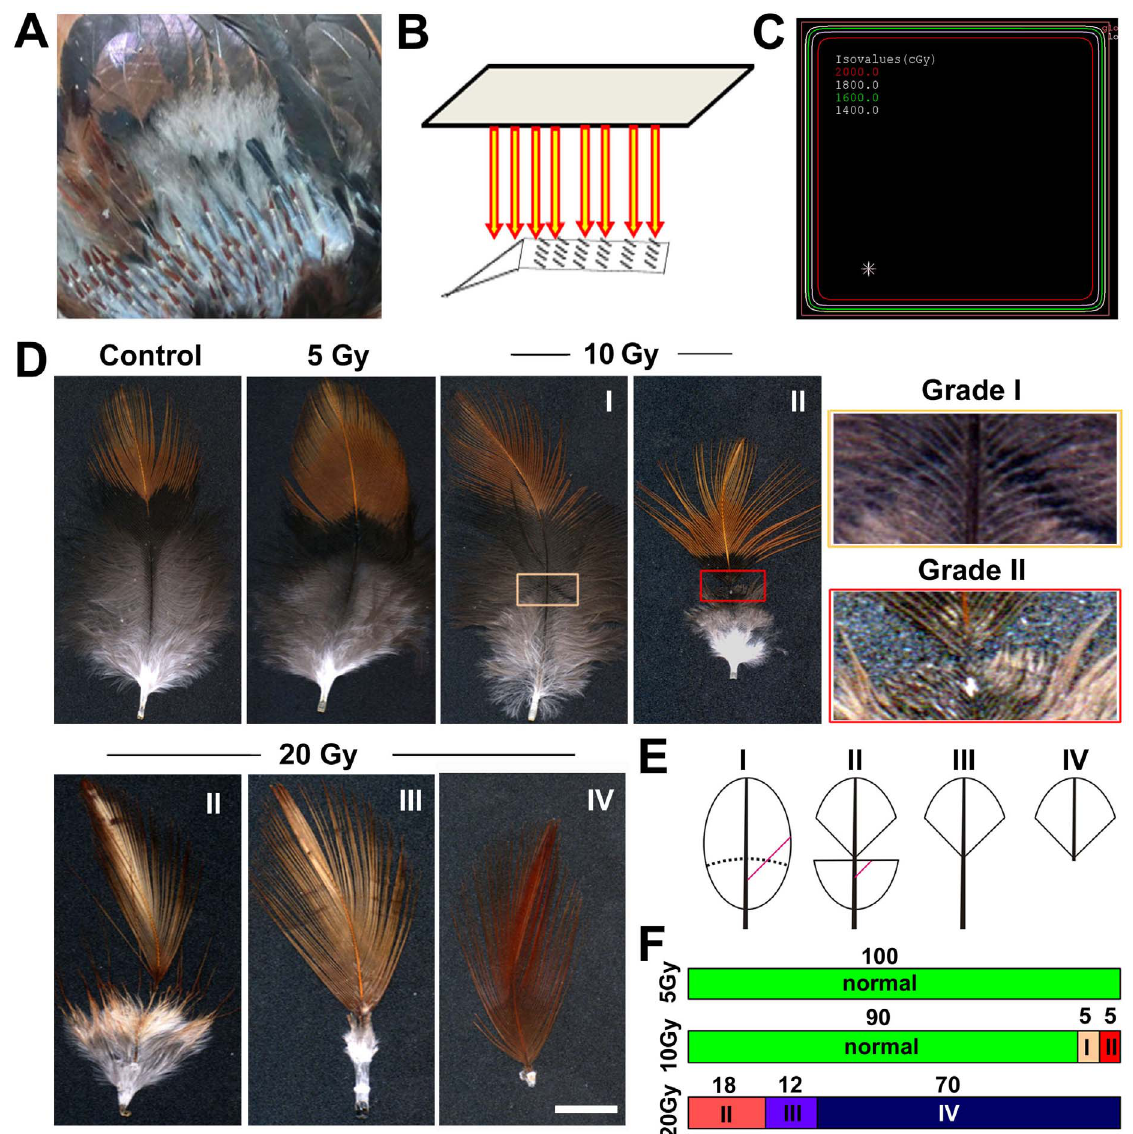
Figure 1. IR induces defects in feather formation in a dose-dependent manner. (A) Feathers in the chicken wing region were plucked 2 weeks earlier to induce active growth. (B) This area was placed under a lead window and exposed to IR. The rest of the body was protected. (C) Homogeneous dose distribution in this exposure window. (D) Phenotypes of feathers after IR exposure. Feathers were collected 3 weeks after exposure, and representative examples are shown. Higher magnifications showing the typical defects in feather morphology. (E) Schematics showing the different grade of defects in the feather. A red line indicates a barb that is retained in grade I defect, but is broken in grade II defect, and not formed in grade III/IV defects. (F) Statistics of the defects at different doses. Feathers from three birds were collected and analyzed for each experimental dose. n=40 at 5 Gy, 40 at 10 Gy and 60 at 20 Gy. Bar=1 cm.